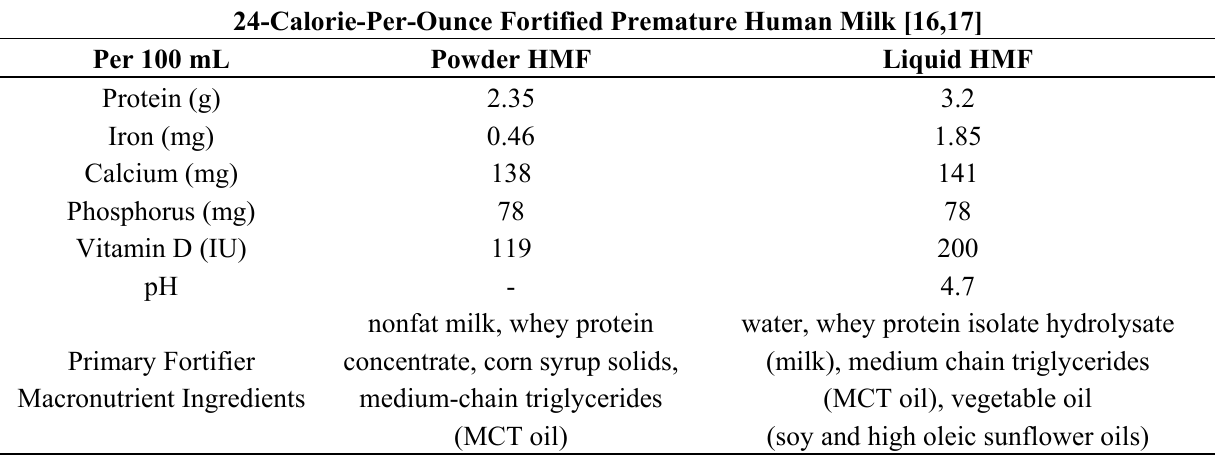
Table 1. Comparison of ingrediants and key nutrients using powder and liquid